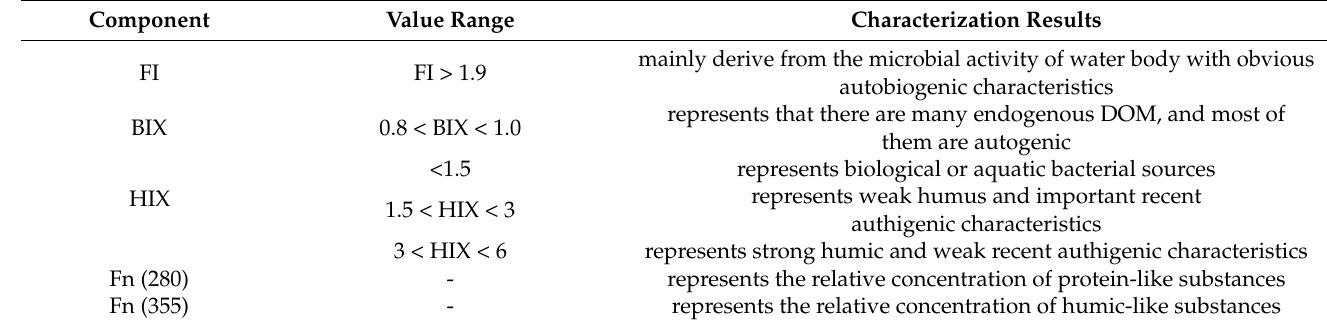
Table 2. Analysis of fluorescence spectrum parameters [32–36].